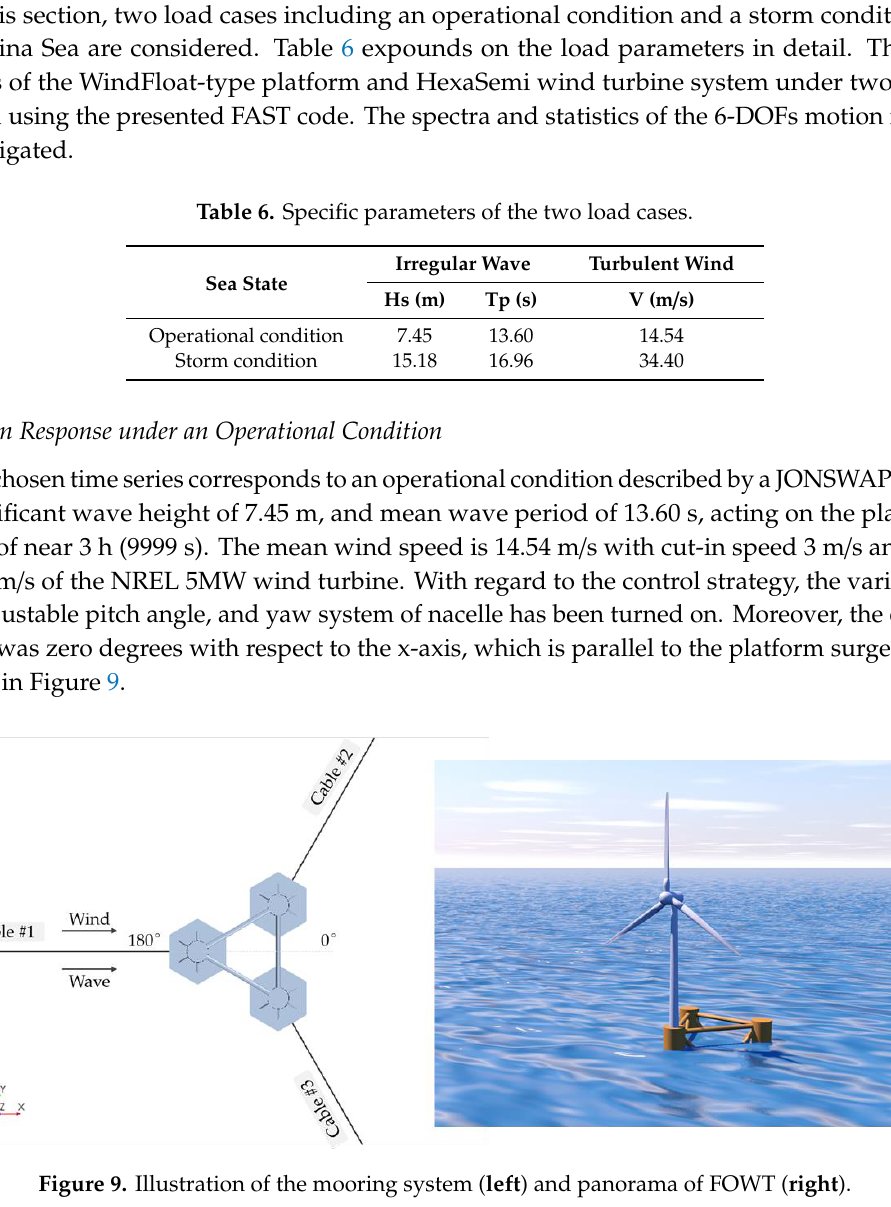
Table 5. Additional linear and quadratic heave damping of the two platforms.